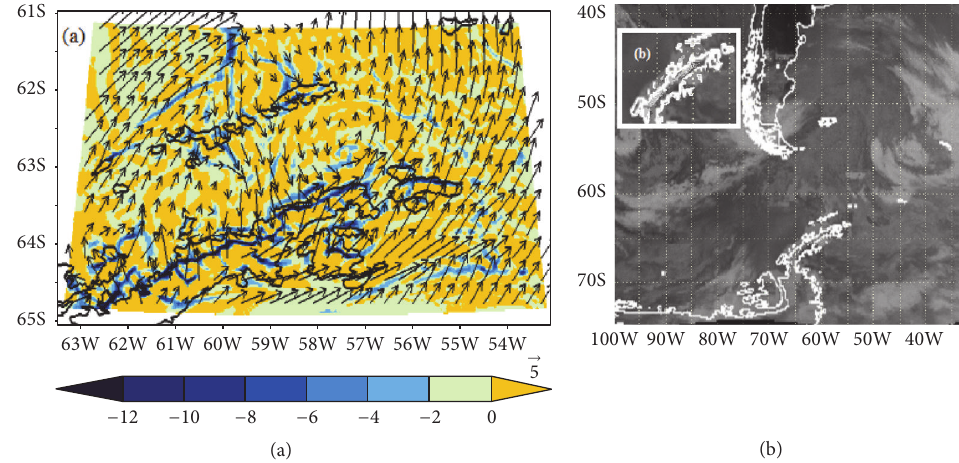
Figure 6: 15 December 2013: (a) 10m wind vectors and horizontal divergence over the inner domain simulated with the WRF model at 22:00 UTC; (b) GOES 13 infrared image (3.9 𝜇 channel) at 20:45 UTC. Inset shows a zoom over the peninsula (source: http://satelite.cptec.inpe.br/acervo/goes.formulario.logic).